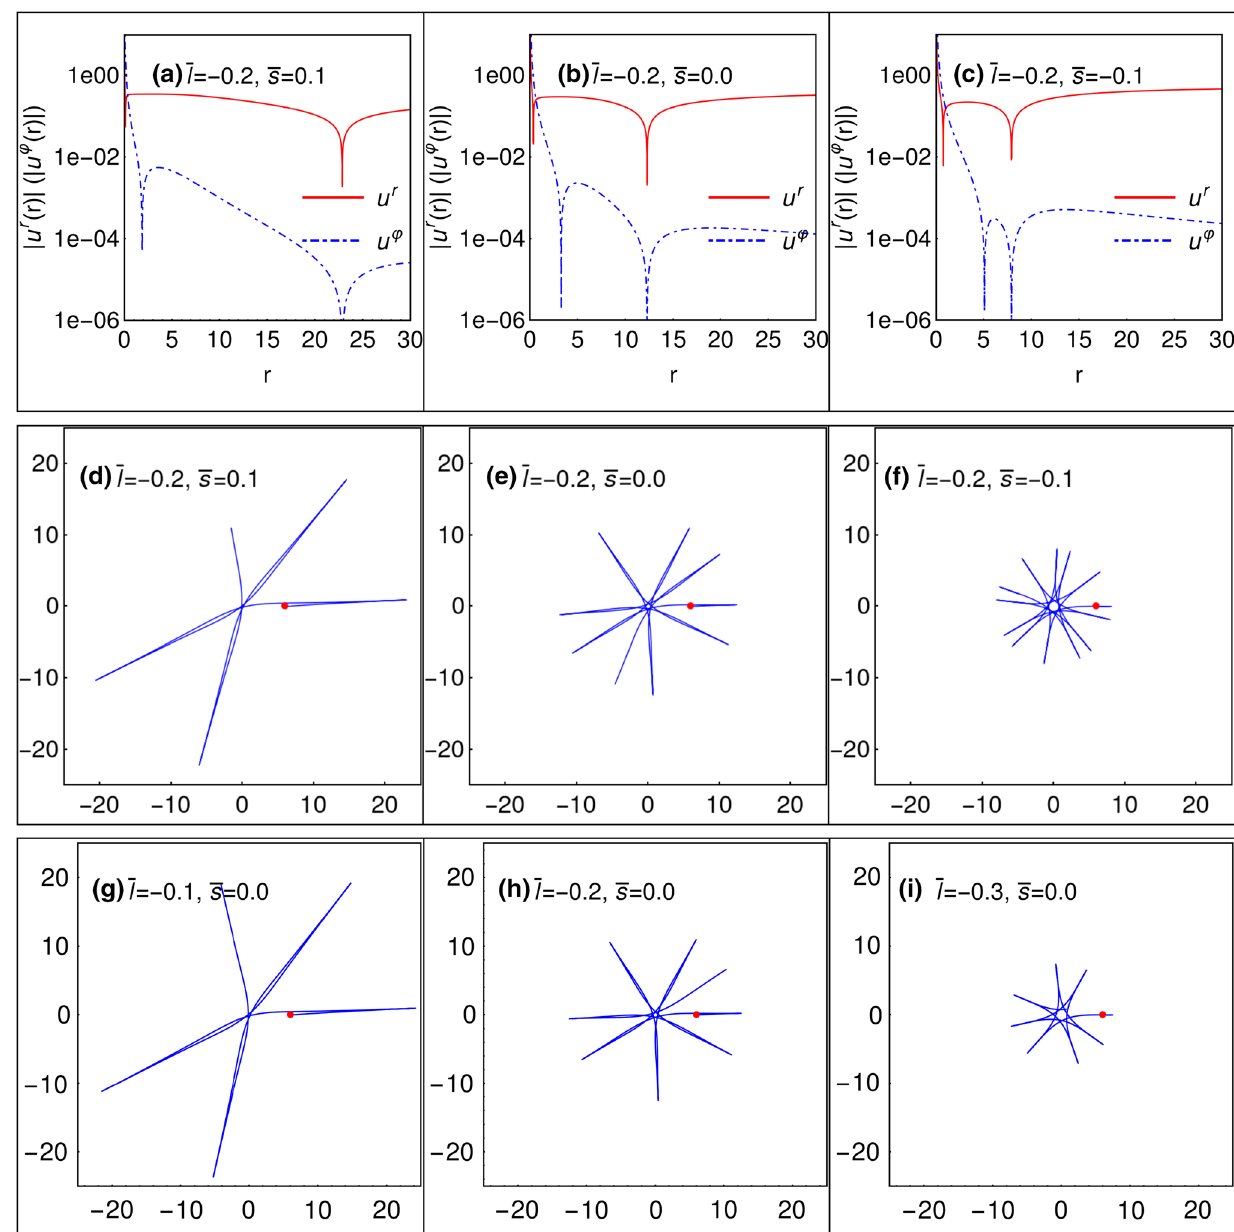
Fig. 6 Plots of the radial and angular velocities (up channel) and orbits with zero radial and zero angular velocities. The middle chan- nel describes the orbits of spinning test particle with the same orbital